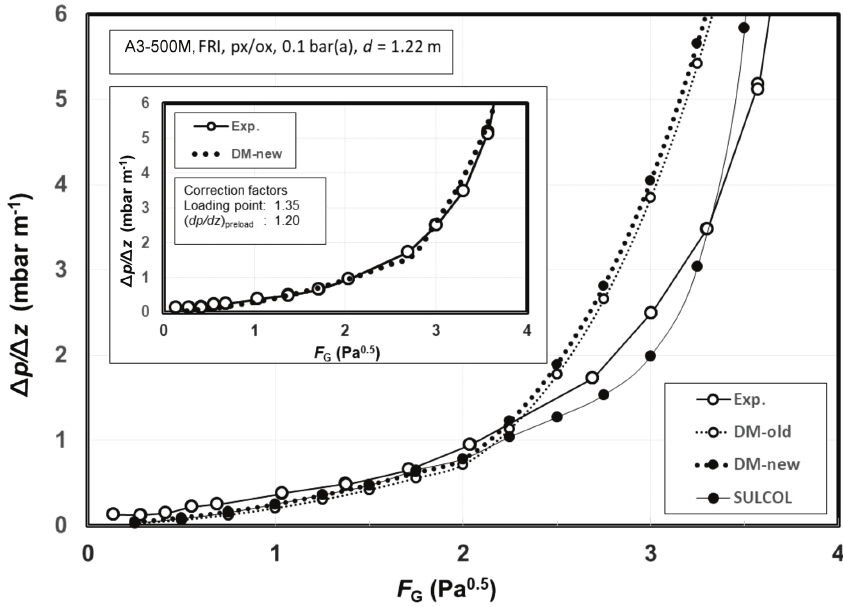
Fig. 14 – Comparison of the specific pressure drop as estimated by original (DM-old) and extended DM (DM-new) for advanced wire gauze corrugated sheet structured packing A3-500M compared with experimental data (FRI, 0.1 bar). SULCOL estimates are related to BXPlus. Inserted graph demonstrates that pressure drop predicted by extended DM utilizing two correction factors, which reflect the extent of deviation in this case, perfectly matches with experiment.